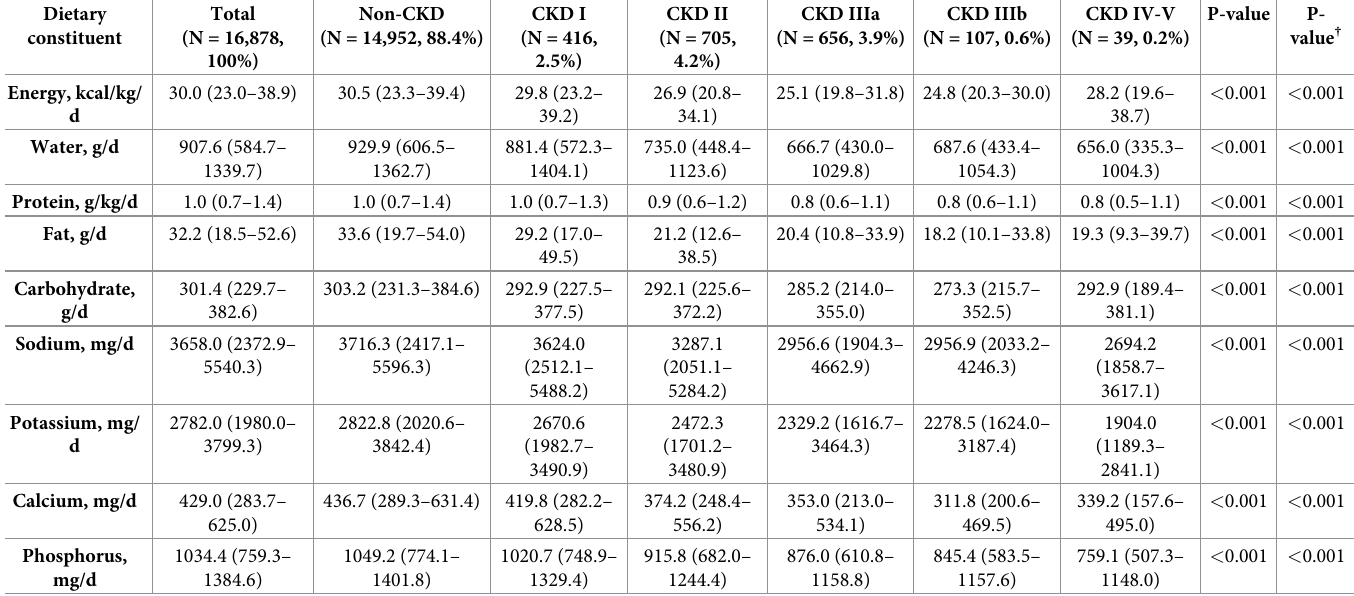
Table 2. Comparisons of the nutritional intake between the